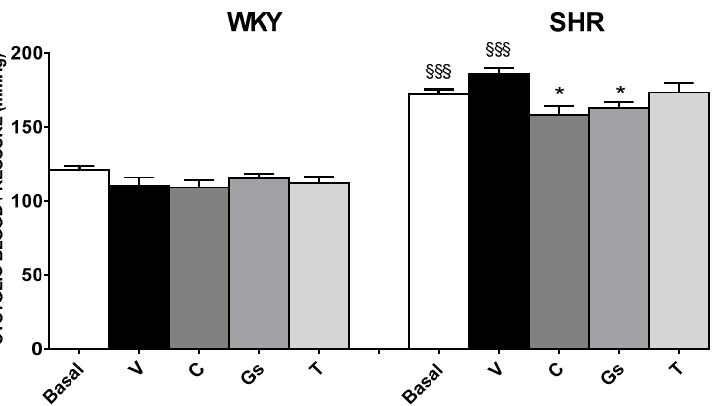
Figure 2. SHRs (right) and WKY (left) rats were treated for four weeks with vehicle (V), captopril (C) (50 mg/kg), tomatine (T) (8 mg/kg) or tomato gel/serum (Gs) (400 mg/kg). Basal: values recorded at the beginning of the four weeks of treatment. Data are reported as mean ± SEM. §§§ p < 0.001 vs. same treatment in WKY; * p < 0.05 vs. SHR V (ANOVA followed by Bonferroni).